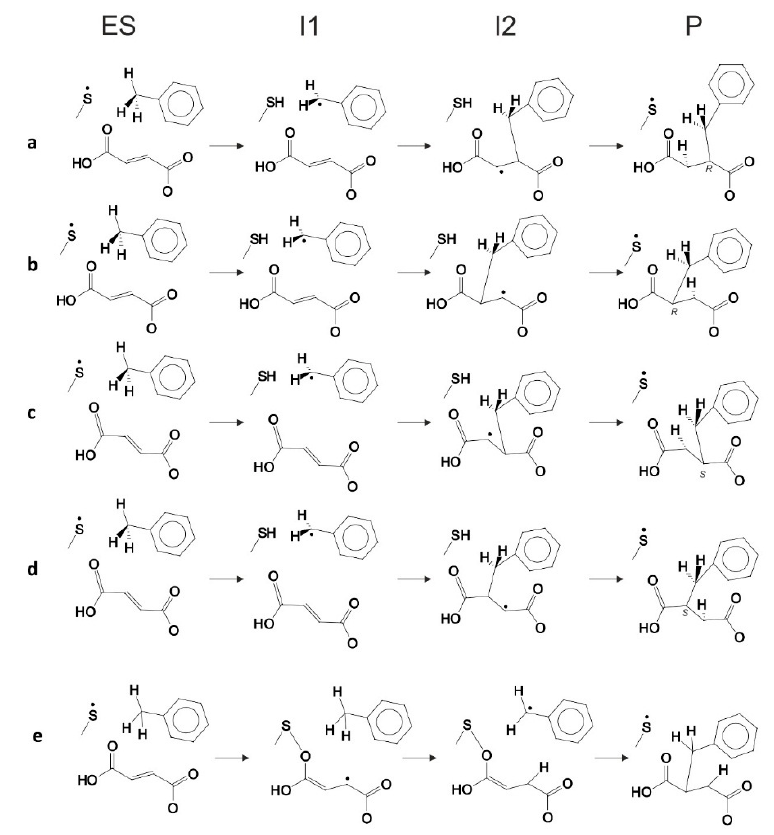
Figure 2. Four pathway variants considered in the study: pro( R )-oriented fumarate with the benzyl radical attacking ( a ) the distal C3 atom or ( b ) the proximal C2 atom of the fumarate; pro( S )-oriented fumarate with the benzyl radical attacking ( c ) the distal C3 atom or ( d ) the proximal C2 atom of the fumarate; ( e ) thiyl radical attacking carboxyl group of the fumarate.